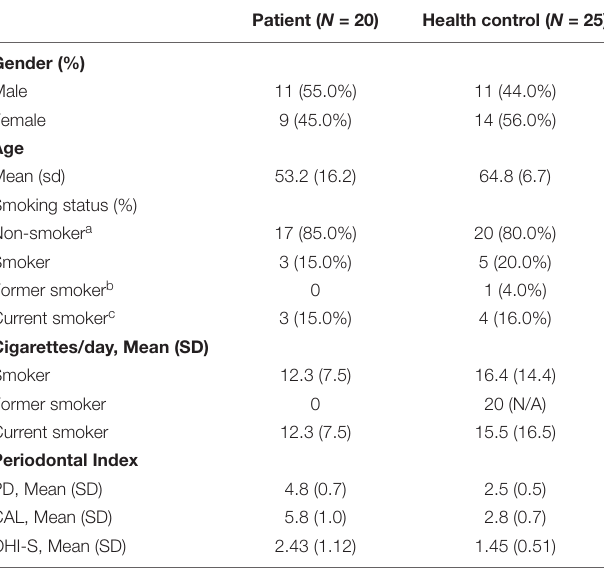
TABLE 1 | Characteristics data of the enrolled study